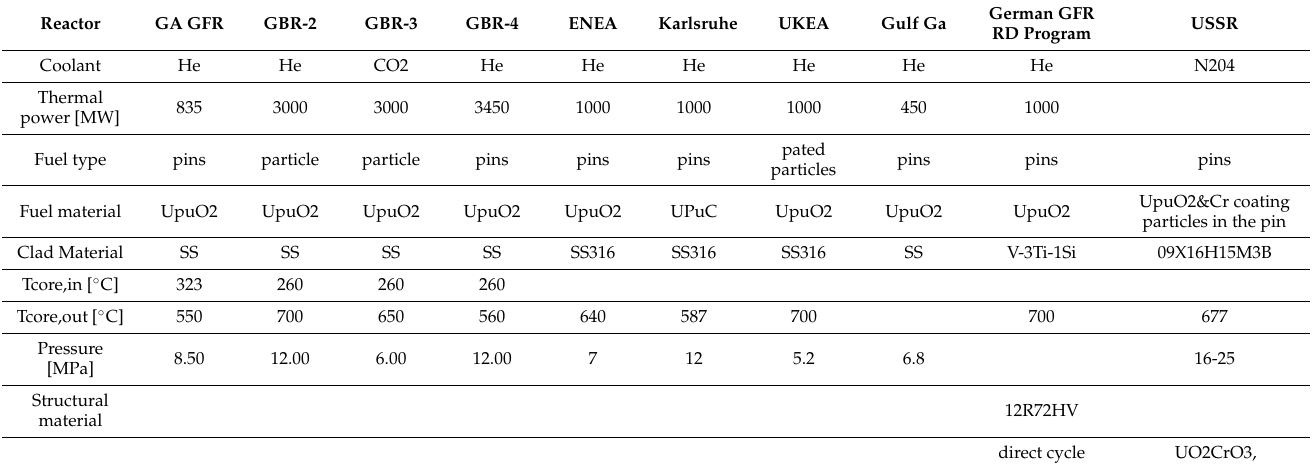
Table 2. Overview of the GFR